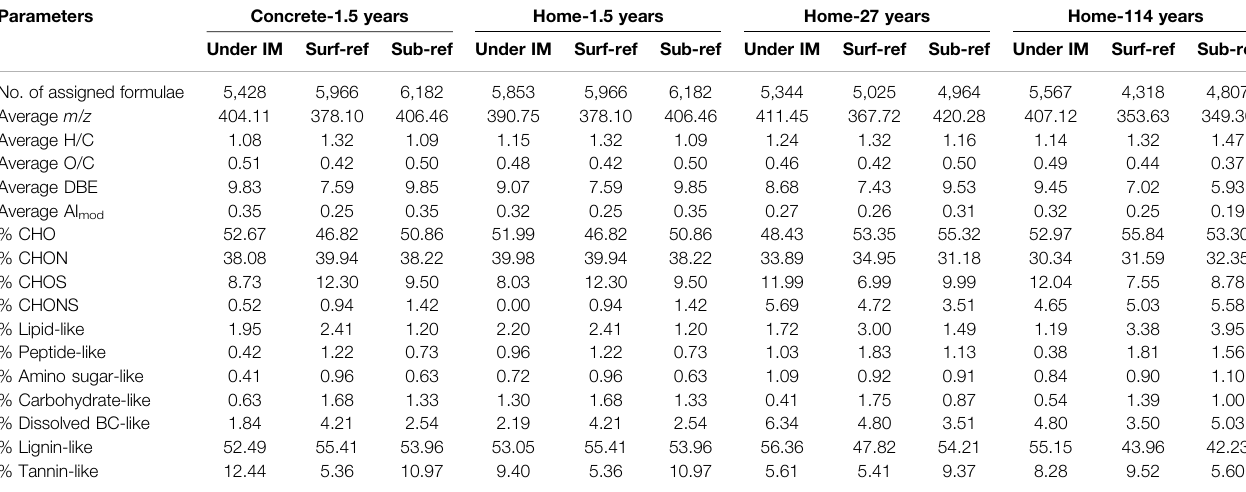
TABLE 1 | Molecular characterization of the solid-phase extracted WEOM in soils with and without coverage by impervious surfaces. Parameters Concrete-1.5 years Home-1.5